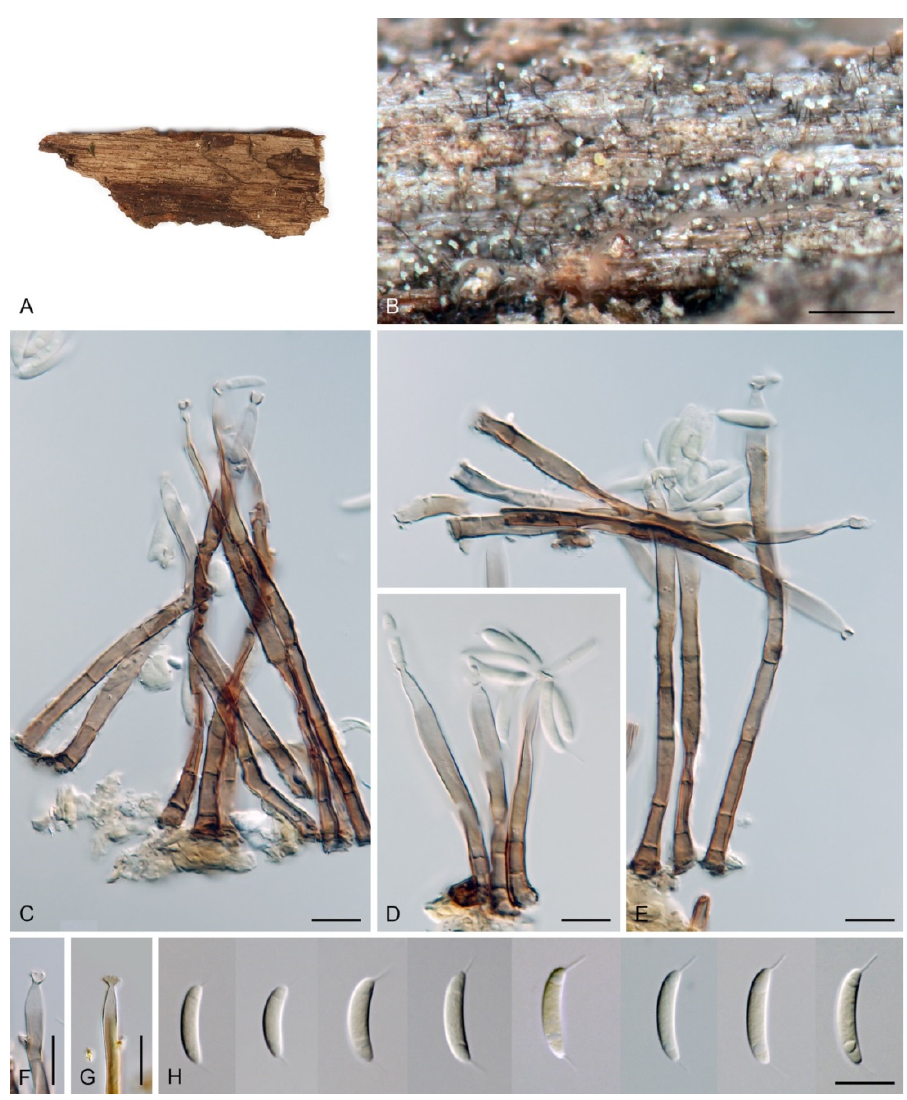
Figure 43. Tainosphaeria parva (DAOM 93565d isotype). ( A ) Substrate with colonies ( B – E ) conidio- phores ( F , G ) tips of the conidiogenous cells ( H ) conidia. Images: ( A – H ) from nature. Scale bars: ( B ) 500 μ m; ( C – H ) 10 μ m.